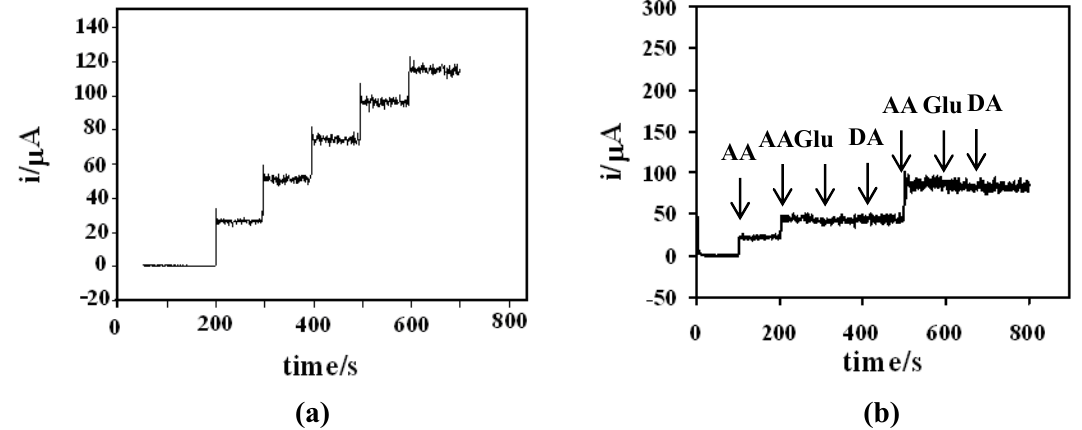
Figure 5. (a) Typical amperometric i - t curve of poly(Ani- co - m -FcAni)/GCE to successive additions of 0.1 mM AA into a stirred system of 0.1 M citrate buffer (pH 5.0) at +0.25 V. (b) Amperometric response for interferences recorded using poly(Ani- co - m -FcAni)/GCE upon successive additions of 0.1 mM AA, 1.0 mM DA and 1.0 mM